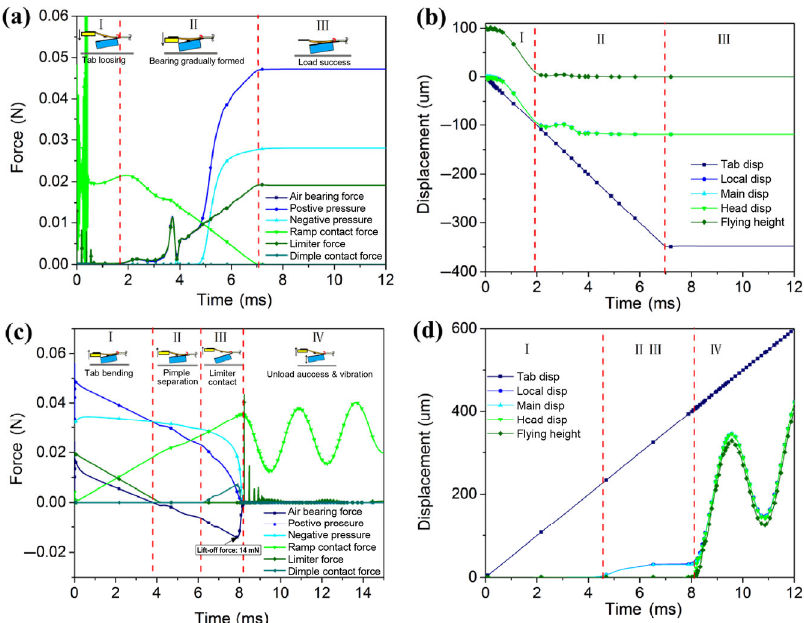
Fig. 9 Load/unload process: (a) force history and (b) components displacements during the load process, (c) force history and (d) components displacements during the unload